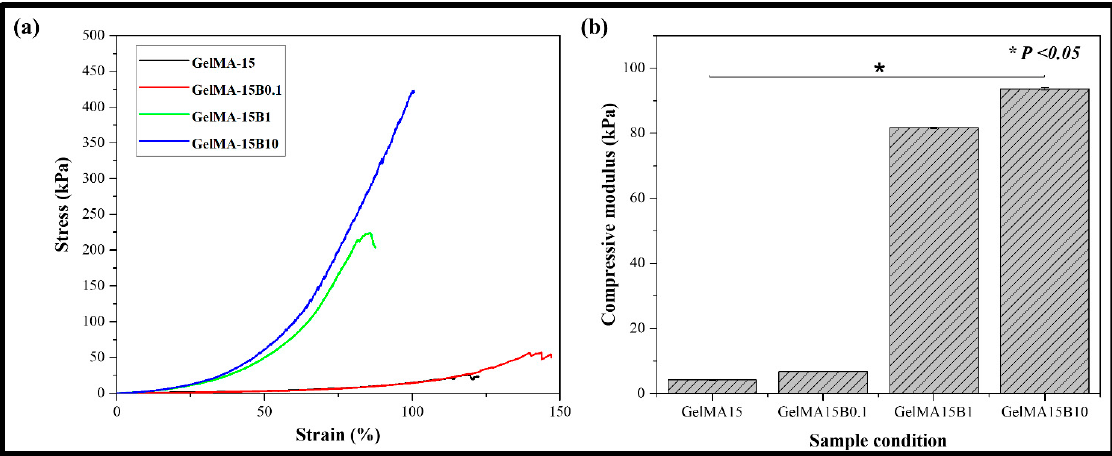
Figure 4. Graphs of ( a ) compressive stress–strain curve and ( b ) compressive modulus on the GelMA-15, GelMA-15B0.1, GelMA-15B1, and GelMA-15B10